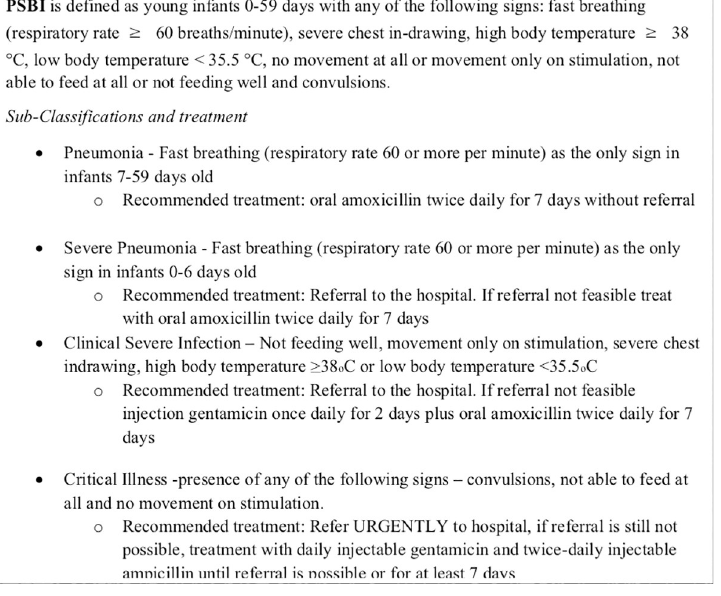
Fig 3. Definitions and treatment for PSBI sub-classifications. PSBI, possible serious bacterial infection. A syndromic classification for health workers using the IMCI algorithm.